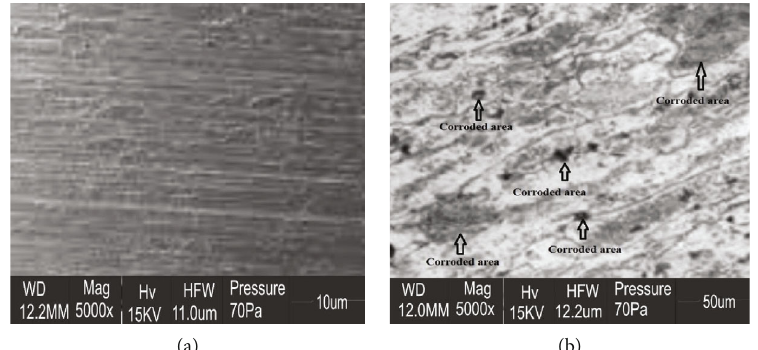
Figure 11: SEM surface morphology of A515 Grade 70 CS in 1.0M HCl for 5 days at temperature 60 ° C with magni fi cation of × 5000 in the (a) presence of 10 gL -1 CMSE and (b) absence of CMSE.